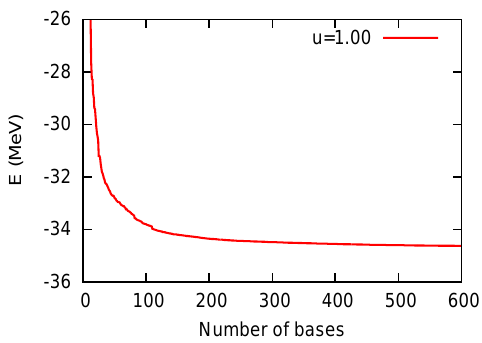
Figure 1: Energy convergence of 6 Li as a function of the number of